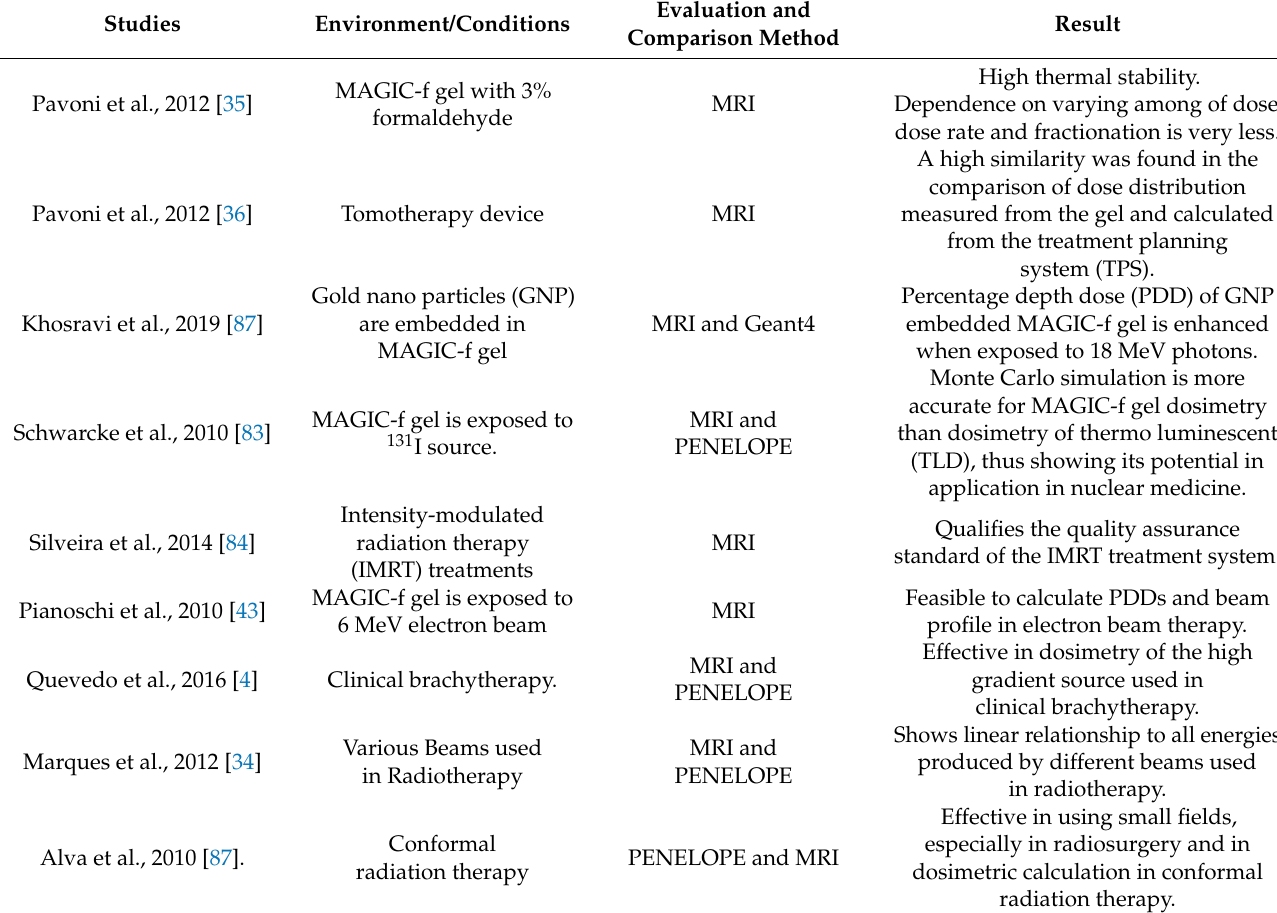
Table 1. Summary of studies on MAGIC-f